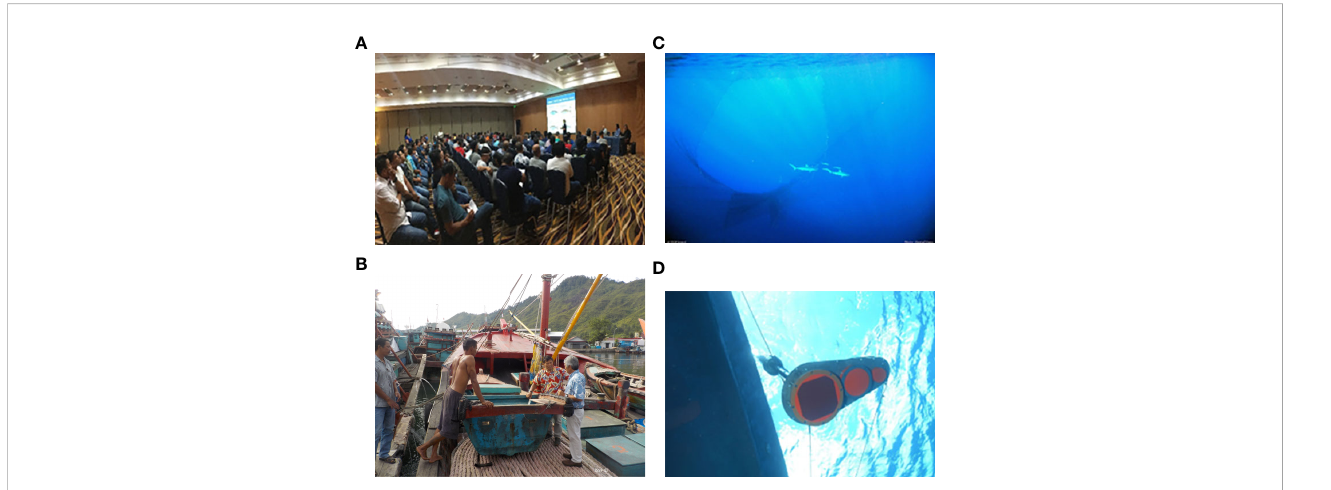
FIGURE 2 ISSF scientists and fi shers (A) in a large-scale workshop at Manta (Ecuador), (B) during a visit to a small-scale purse seiner in Sibolga (Indonesia), (C) trials with shark escape windows in the net in the Western Paci fi c Ocean, and (D) multi-frequency echosounder transducers to improve tuna species discrimination in FADs tested during research